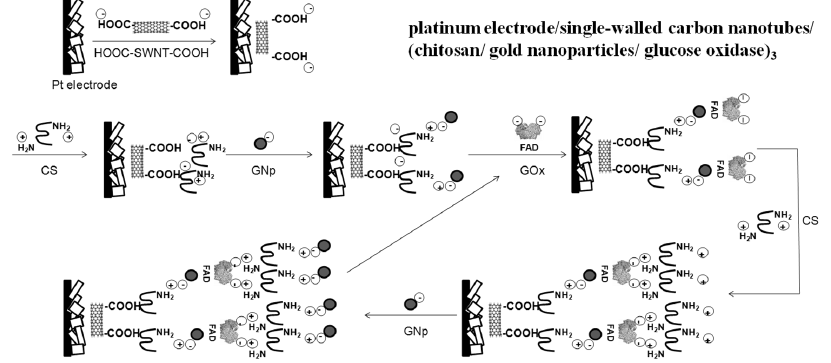
Figure 2. Schematic illustration of the layer-by-layer self-assembly procedure.